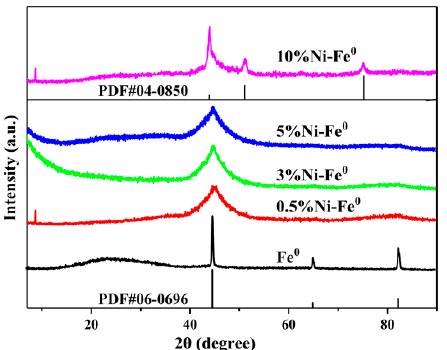
Figure 1. XRD images of nZVI and Ni-nZVI with different nickel contents.